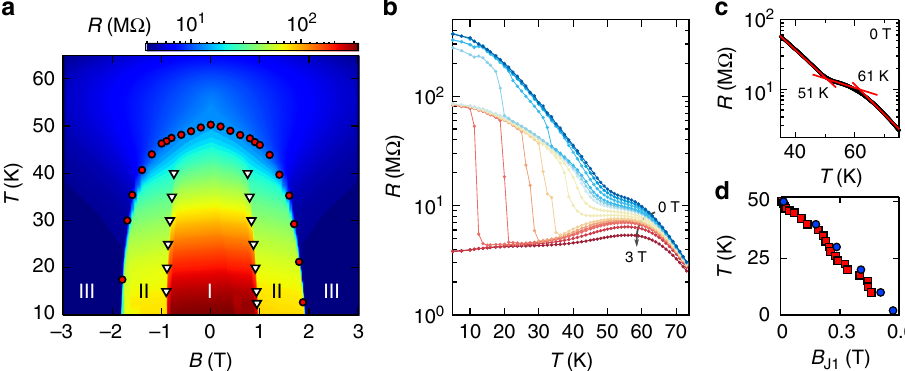
Fig. 4 Temperature and magnetic fi eld evolution of magnetic states in CrI 3 . a Color plot of the resistance of the device shown in Fig. 1d (in logarithmic scale), as a function of B and T . At low temperature, three clear plateaus signal the presence of different magnetic states (labeled I, II, III). The white triangles and red circles, obtained from the position of the resistance jumps as described in the text, outline the boundaries of these states, and show that the magnetoresistance features appear at T ≅ 51 K (i.e., in correspondence of the anomaly seen in the low- fi eld magnetization; Supplementary Fig. 1c-d). b T -dependence of the resistance (in logarithmic scale) at different fi xed values of B : three different values are attained at low-temperature, corresponding to the different magnetic states of CrI 3 . c T -dependence of the resistance measured at B = 0 T. The kink at T ≅ 51 K originates from the evolution of the boundaries between II and III; the ferromagnetic transition manifests itself as a kink around 61 K. d Temperature dependence of the position of jump J1 (clearly seen in Fig. 3 in linear scale; the logarithmic scale in Fig. 4a makes jump J1 dif fi cult to discern). The blue and red symbols — measured 8 months after each other — demonstrate the excellent reproducibility and stability of encapsulated CrI 3